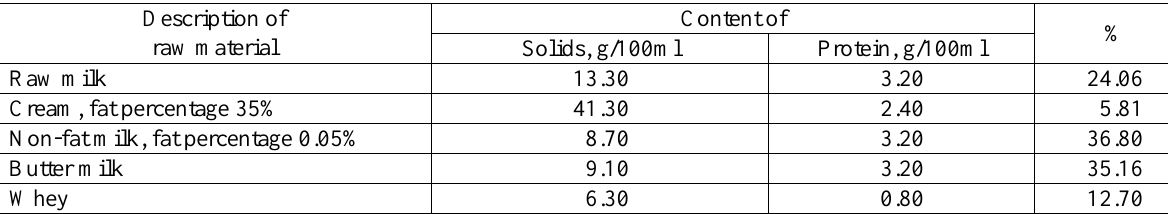
Table 1. Content of albumins in raw milk Description of